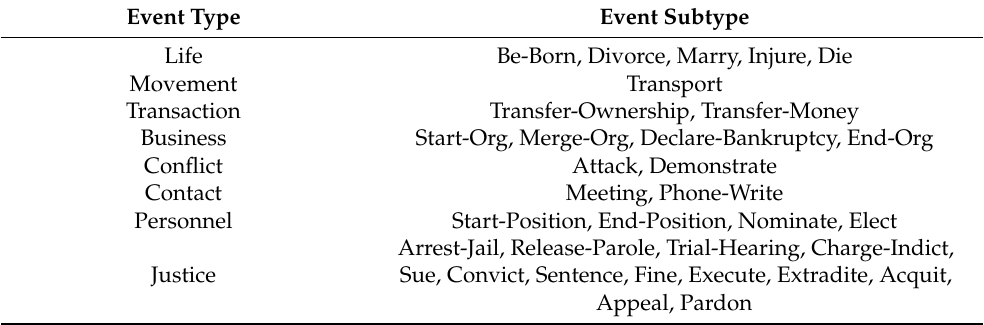
Table 1. Event type list.